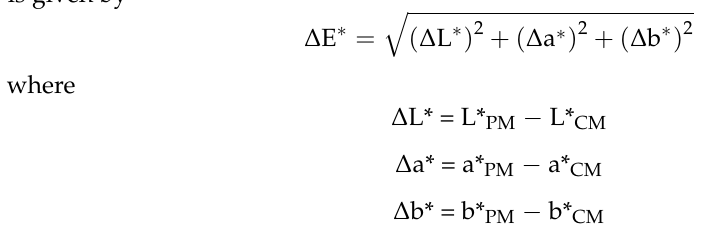
Figure 2. The test-piece device. The tsavorite sample was placed on top of the background. The spectrophotometer gathered the color signals, and the color information was then sent to a com- puter for analysi. for